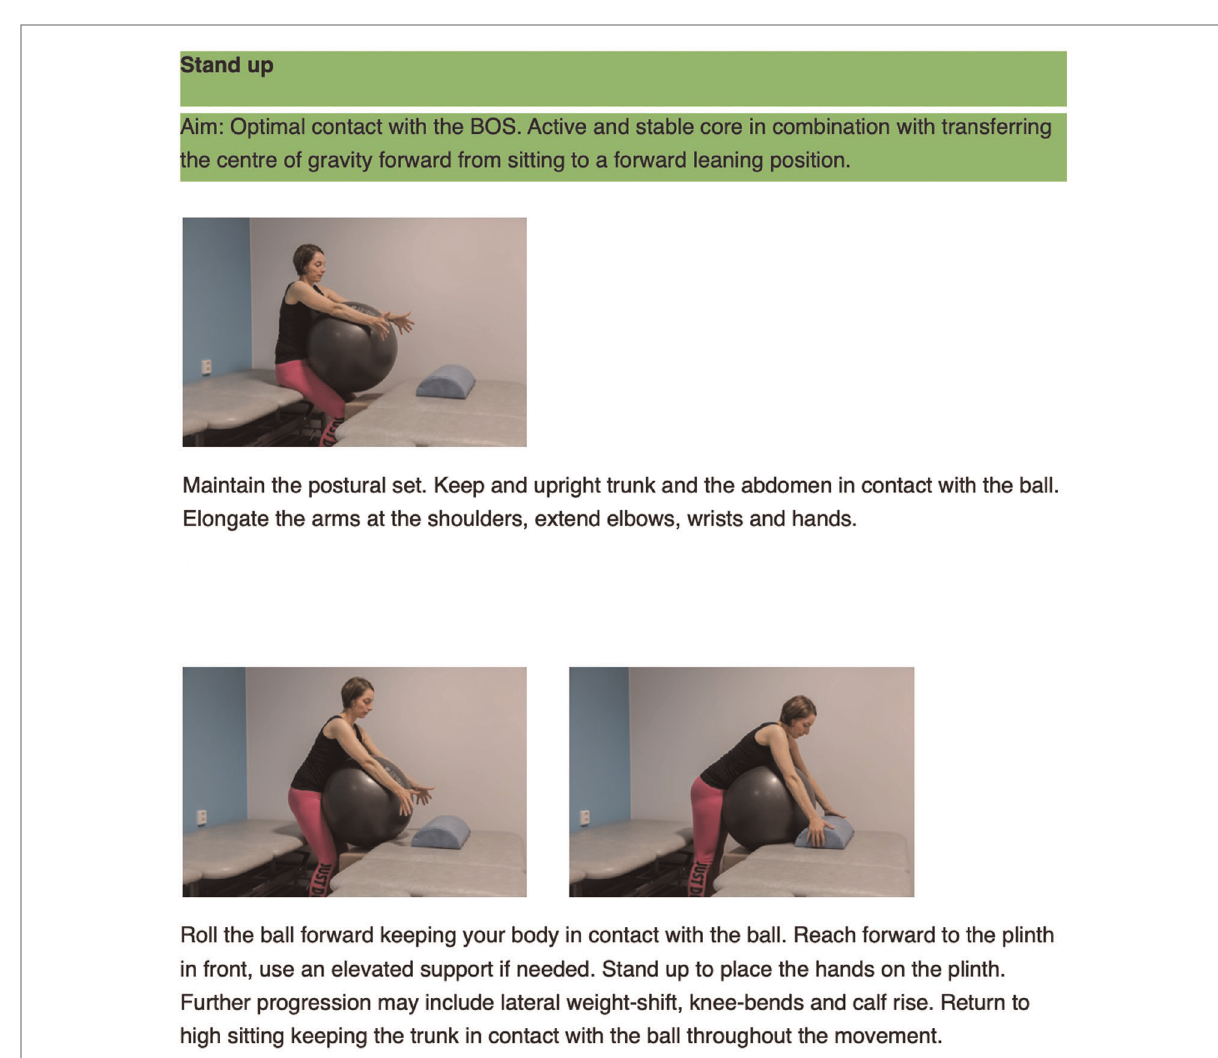
FIGURE 4 Example of exercise that aim for optimal adaptation to the base of support, an active core while practicing transferring the centre of gravity forward as in a sit to stand